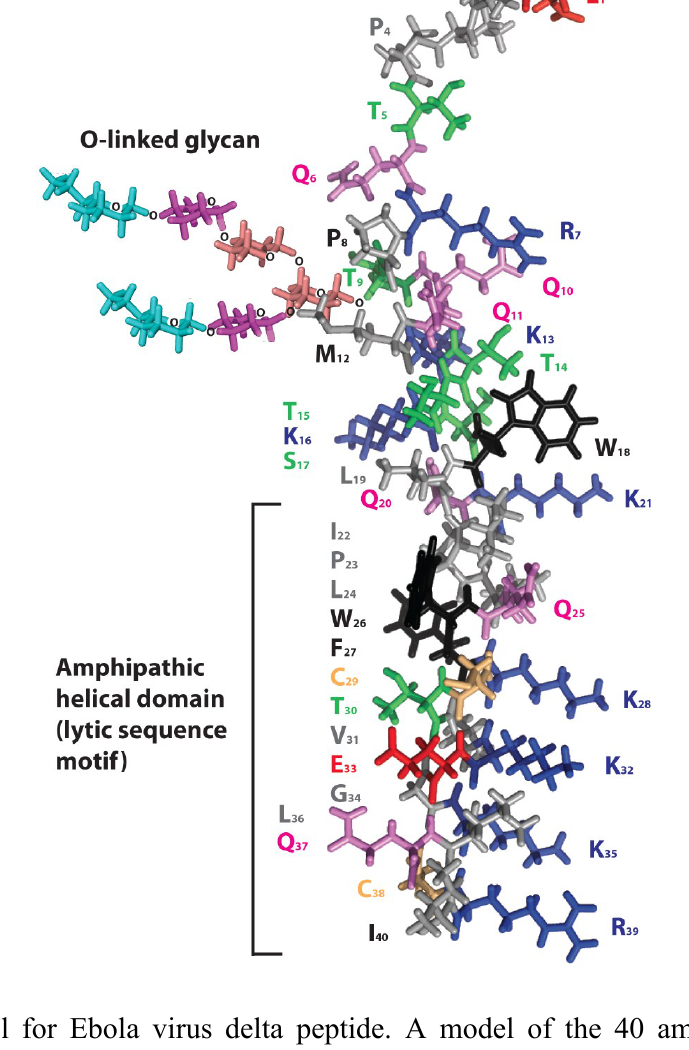
Figure 3. Model for Ebola virus delta peptide. A model of the 40 amino acid peptide sequence of Ebola virus 2014 (EBOV/SLE14-EM95) delta peptide was rendered in PyMol [36] using secondary structural predictions from PredictProtein [40] for the amino terminal half. The carboxyl terminal half of the delta peptide is depicted as an amphipathic alpha helix to emphasize the alignment of positively charged amino acids (lysine and arginine, blue). The carboxyl terminus may not form an alpha helix in a potential alternative configuration of delta peptide in which cysteine 29 and 38 (colored gold) are disulfide-bonded. Aromatic amino acids (tyrosine and tryptophan) are colored black, serine and threonines are colored green, glutamine is colored violet, and the negatively charged amino acid glutamic acid is colored red. The adduct sugar moiety indicates the site of O-glycosylation of delta peptide at threonine 9 of the peptide; the innermost N-acetyl galactosamine is shown in salmon, galactose in purple, and the terminal N-acetyl neuraminic (sialic) acid in cyan. A potential additional O-linked glycan is present at threonine